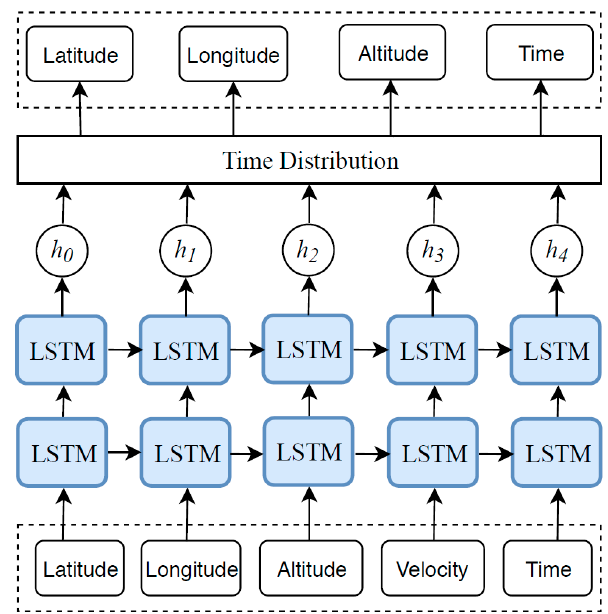
Figure 5. Proposed long short-term memory (LSTM) architecture for the ATRP.